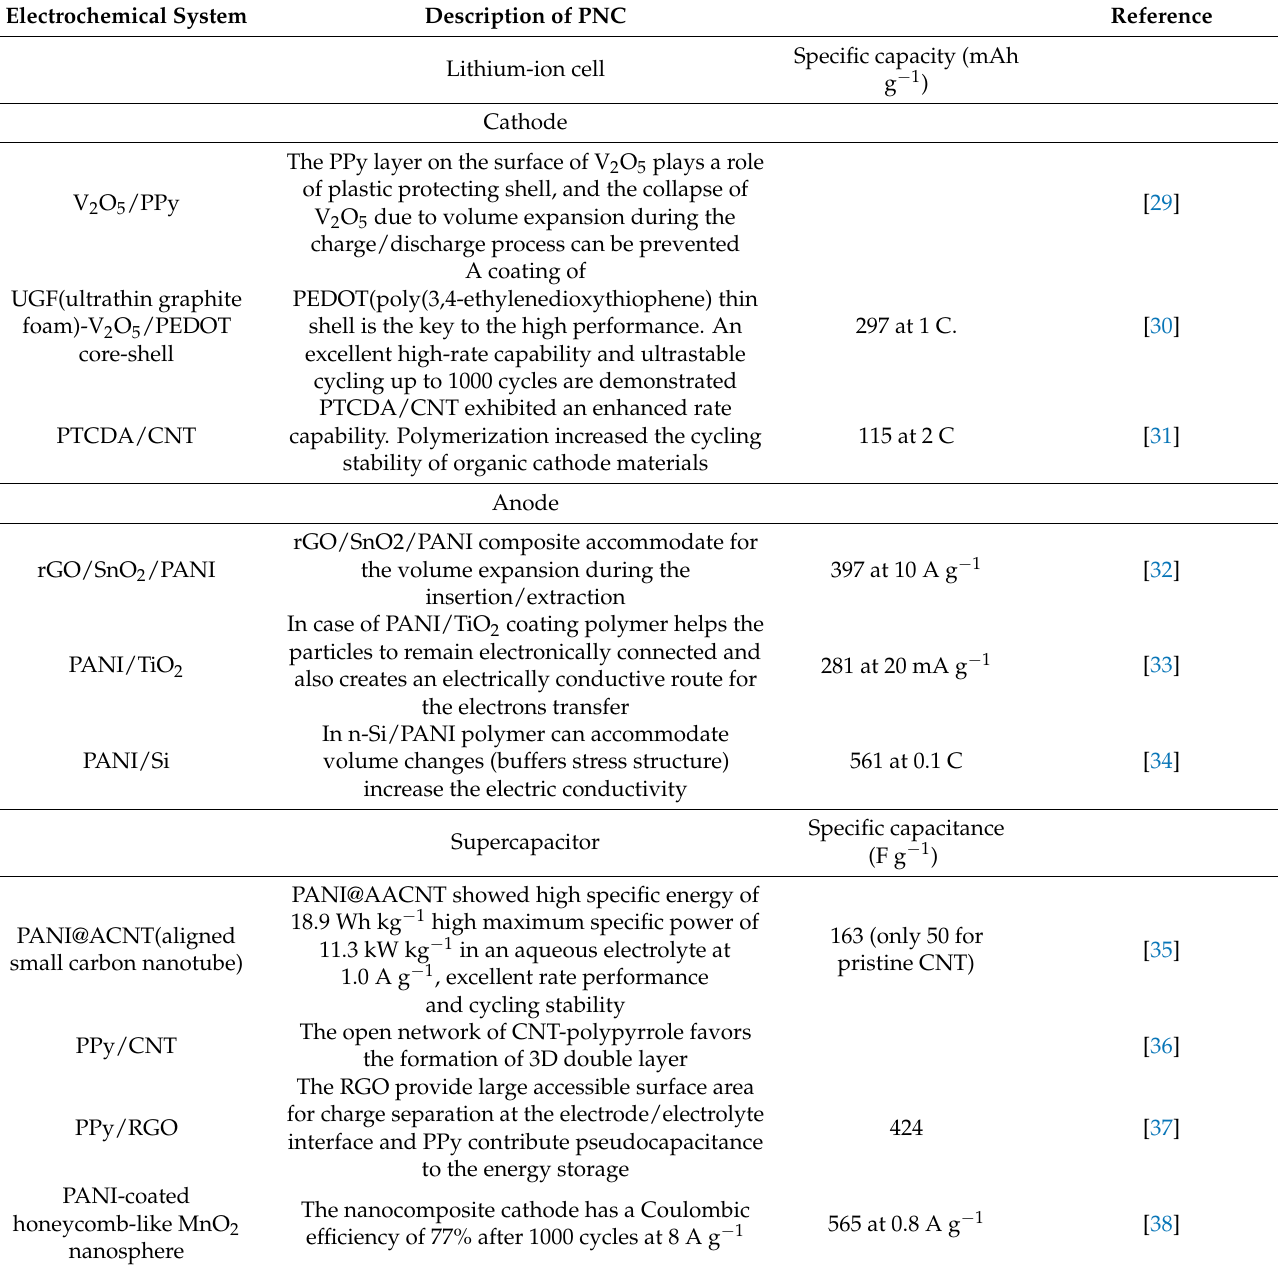
Table 2. Polymeric nanocomposites (PNCs) systems applied in Lithium-ion batteries (LIBs) and supercapacitors as electrode